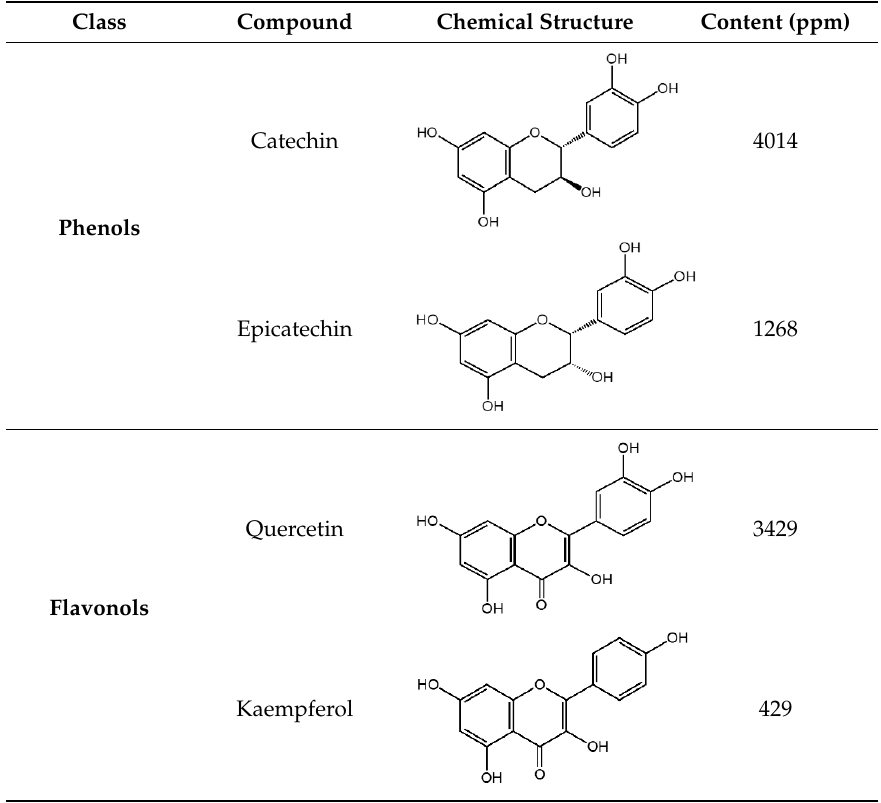
Table 1. Liquid Chromatography with tandem mass spectrometry (LC-MS/MS) analysis of the GPE (grape powder extract) and chemical structures of its compounds.